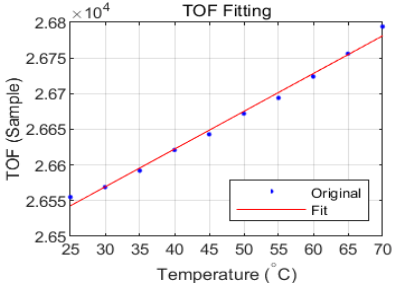
Figure 4. Fit of TOF versus temperature from 25 °C to 70 °C.